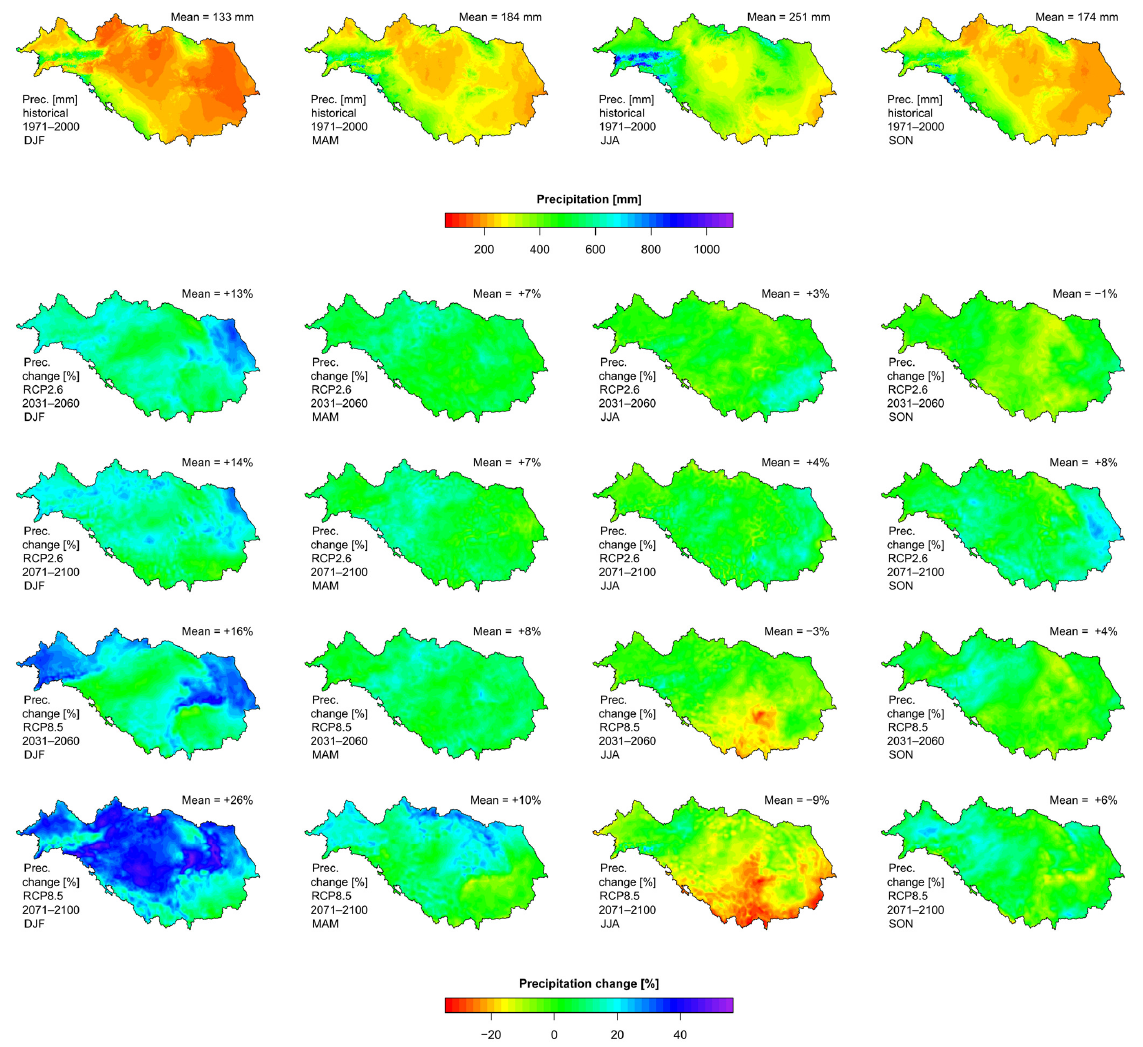
Figure 7. Maps of the long-term mean seasonal precipitation [mm] for the historical GCM-RCM- driven simulations (ensemble mean, 1971–2000) as well as the long-term mean seasonal precipitation change [%] according to the GCM-RCM-driven simulations (ensemble mean) under RCP2.6 and RCP8.5 for the near future (2031–2060) and the far future (2071–2100) in the Danube River Basin.